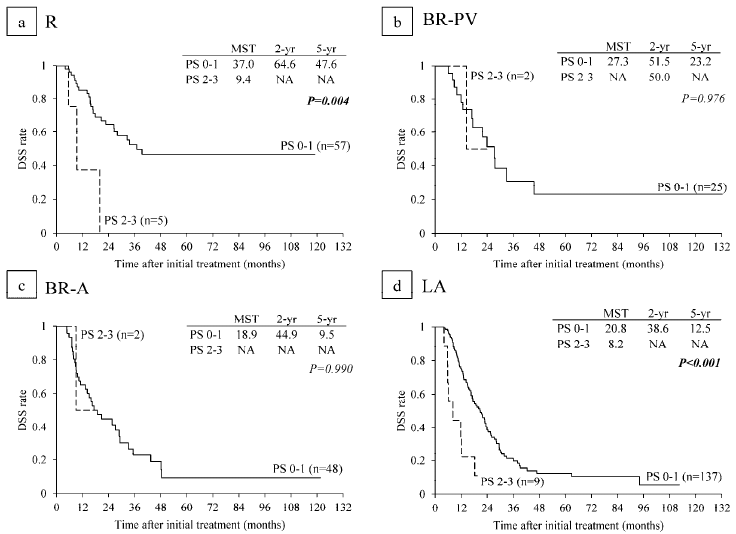
Figure 7. Disease-specific survival (DSS) curves according to performance status (PS) in ( a ) R (n = 62), ( b ) BR-PV (n = 27); ( c ) BR-A (n = 50); and ( d ) LA (n = 146). R: resectable, BR-PV: borderline resectable (superior mesenteric vein/portal vein invasion alone), BR-A: borderline resectable (arterial invasion), LA: locally advanced, MST: median survival time (months), NA: not applicable.